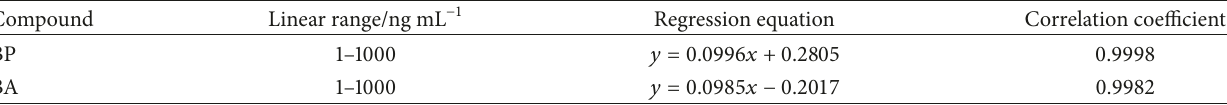
Table 2: Regression equation and correlation coefficients for BP and BA ( 𝑦 = peak area ratio of BP or BA versus IS; 𝑥 = concentration of BP or